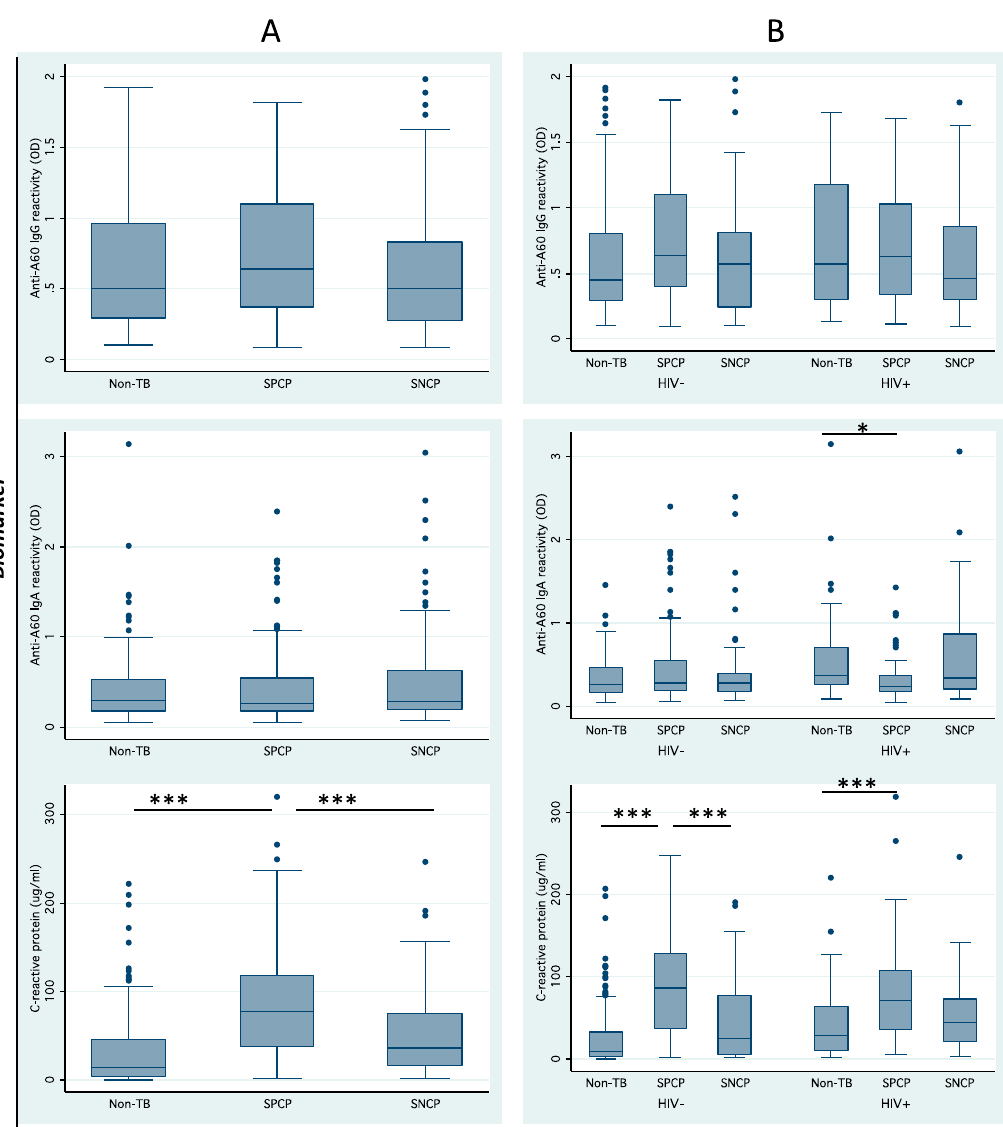
Figure 1. Biomarker distribution. Boxplots of anti-A60 immunoglobulin G (IgG), anti-A60 immunoglobulin A (IgA) and C-reactive protein (CRP) across diagnostic groups ( A ) without HIV status and ( B ) with HIV status taken into account demonstrates influence of HIV on biomarker distribution. Error bars indicate standard deviation. Asterisks indicate statistical significance of p < 0.05 (*), p < 0.01 (**) and p < 0.001 (***). CRP levels >6 µ g/mL was considered above normal.